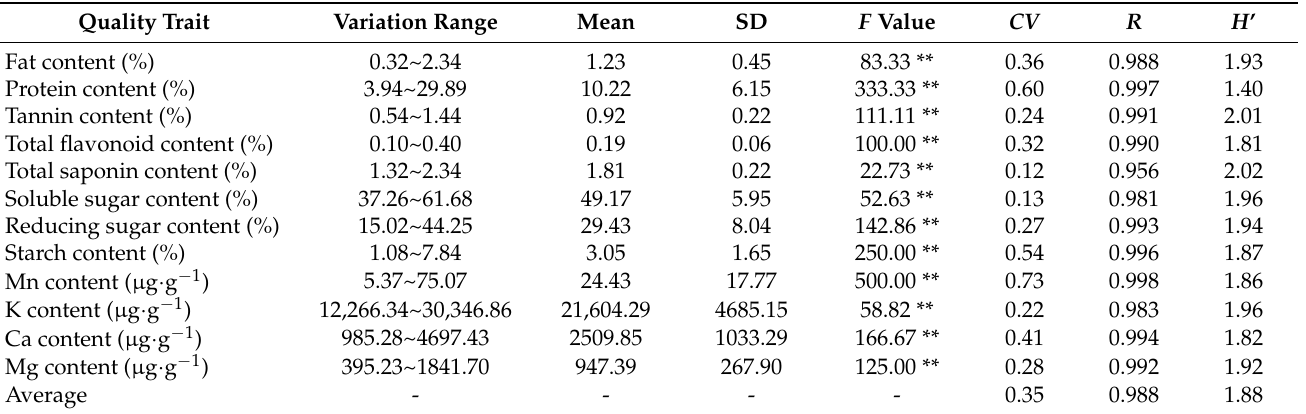
Table 3. Genetic diversity of infructescence quality traits in H. acerba germplasm.